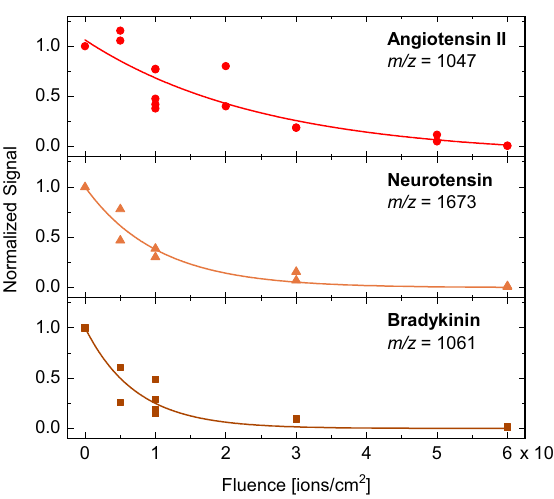
Figure 6. Signal intensity of the peaks associated with the intact oligopeptides as a function of SHI fluence for ( a ) angiotensin II, ( b ) neurotensin, and ( c ) bradykinin. Each data point represents the measurement of a separate sample which was irradiated with the given fluence; the signal of each irradiated sample was referenced to the signal of the same sample prior to irradiation. Exponential fits to the experimental data are represented by solid lines. The variance in the experimental data may be in part explained by variations of the sample position probed during the DINeC measurements prior to and after irradiation as well as by some inhomogeneity of the